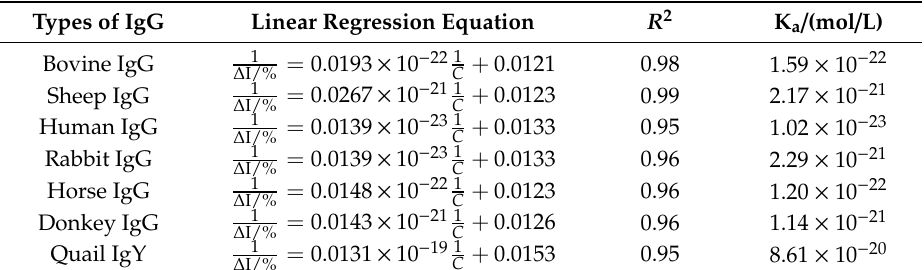
Table 1. Linear regression equation, R 2 and K a of seven IgGs in a certain concentration range after interaction with hFc γ